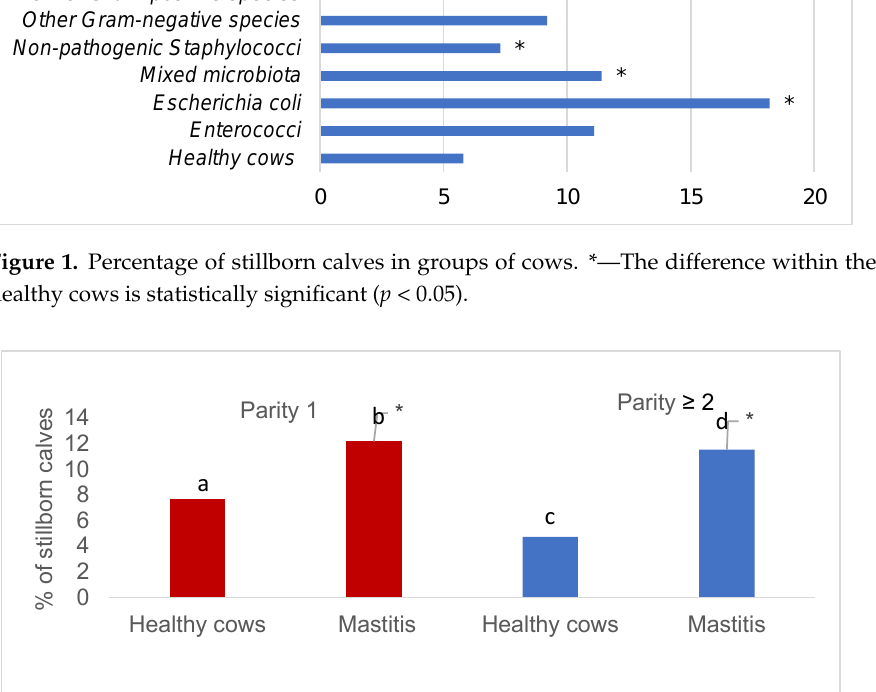
Figure 1. Percentage of stillborn calves in groups of cows. *–The difference within the group of healthy cows is statistically significant ( p < 0.05).